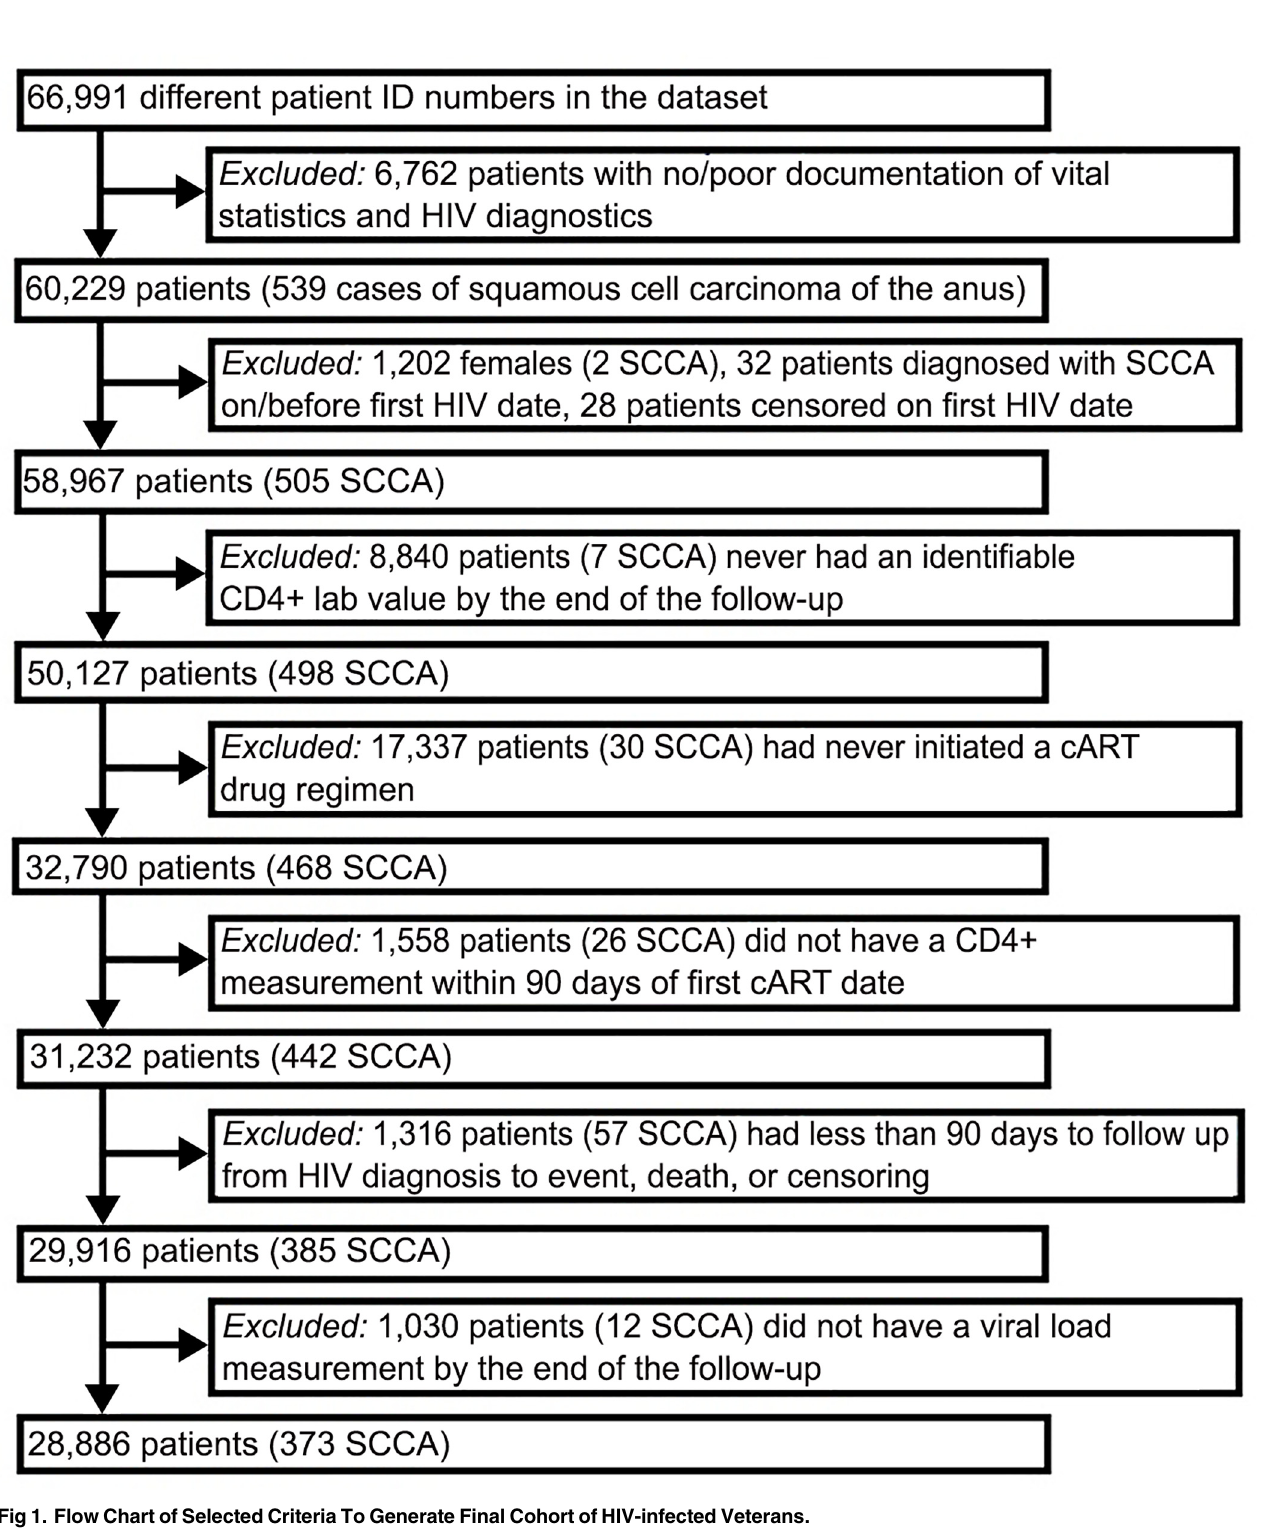
PLOS ONE | DOI:10.1371/journal.pone.0142966 December 2,